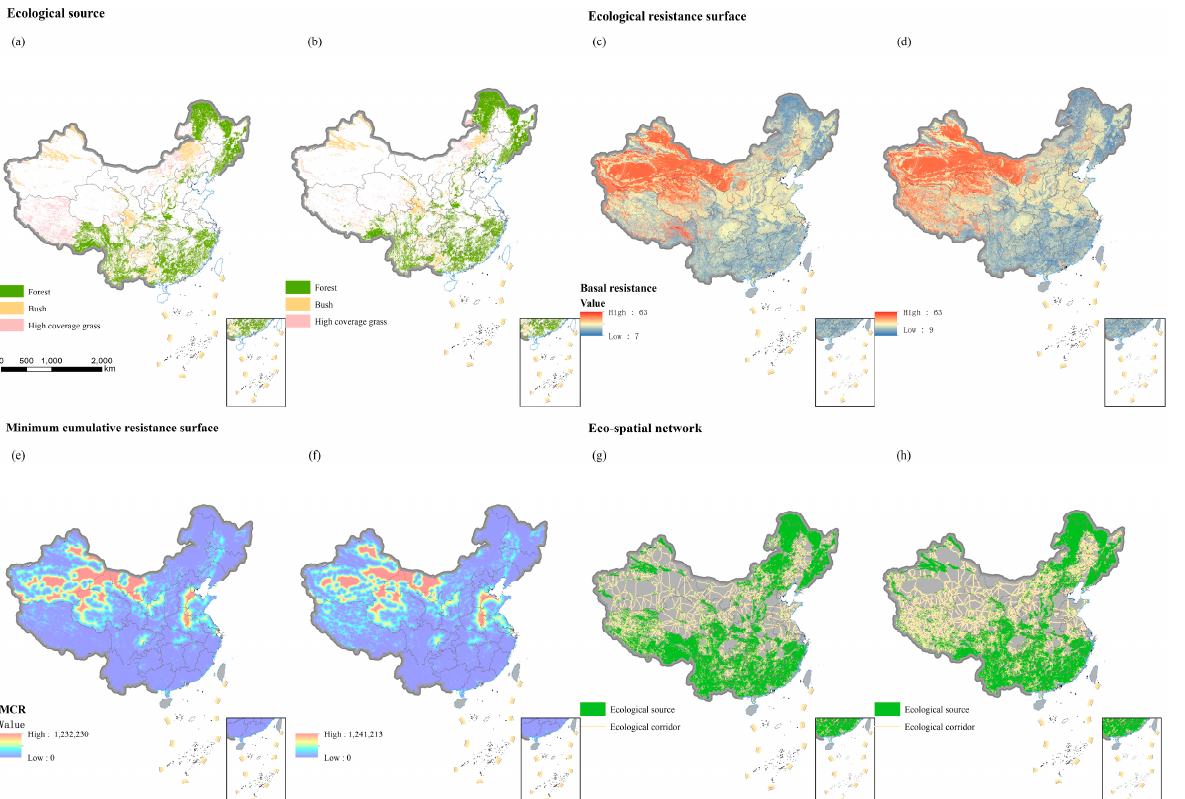
Figure 7. Temporal and spatial evolution of China’s eco − spatial network from 2005 to 2020. ( a ) Ecological source in 2005; ( b ) Ecological source in 2020; ( c ) Fundamental resistance surfaces in 2005; ( d ) Fundamental resistance surfaces in 2020; ( e ) Minimum cumulative resistance value in 2005; ( f ) Minimum cumulative resistance value in 2020; ( g ) Ecospatial network in 2005; ( h ) Ecospatial network in 2020.